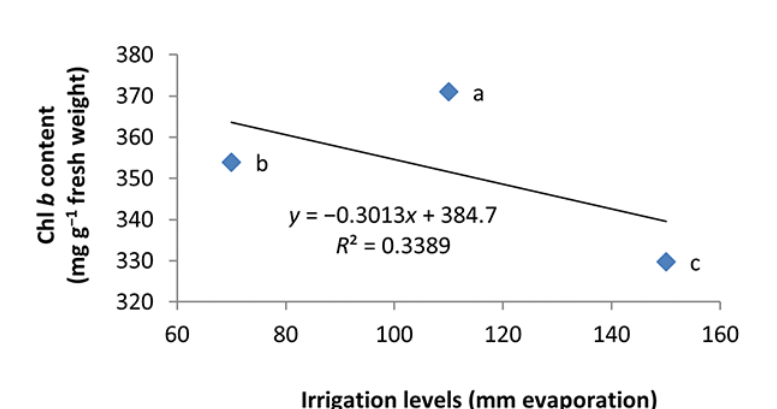
Figure 3 Effect of different irrigation levels on chlorophyll b (Chl b ) content in peppermint.